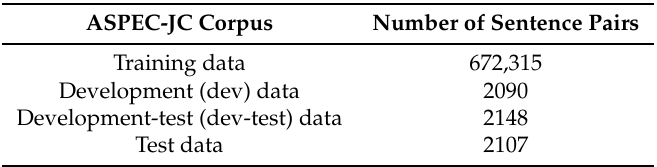
Table 3. The information of the ASPEC-JC corpus.